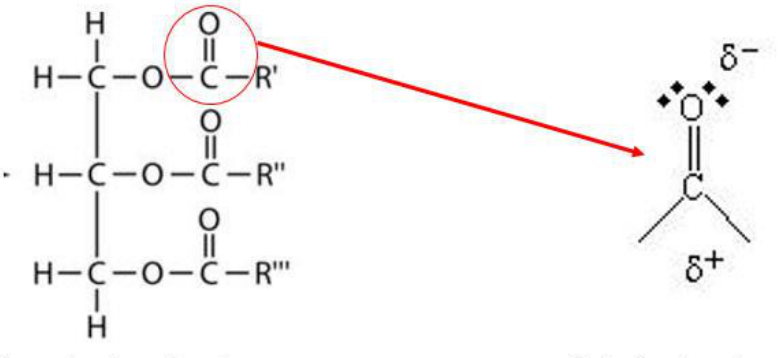
Figure 1. Triacylglycerol backbone and polar carbonyl groups.